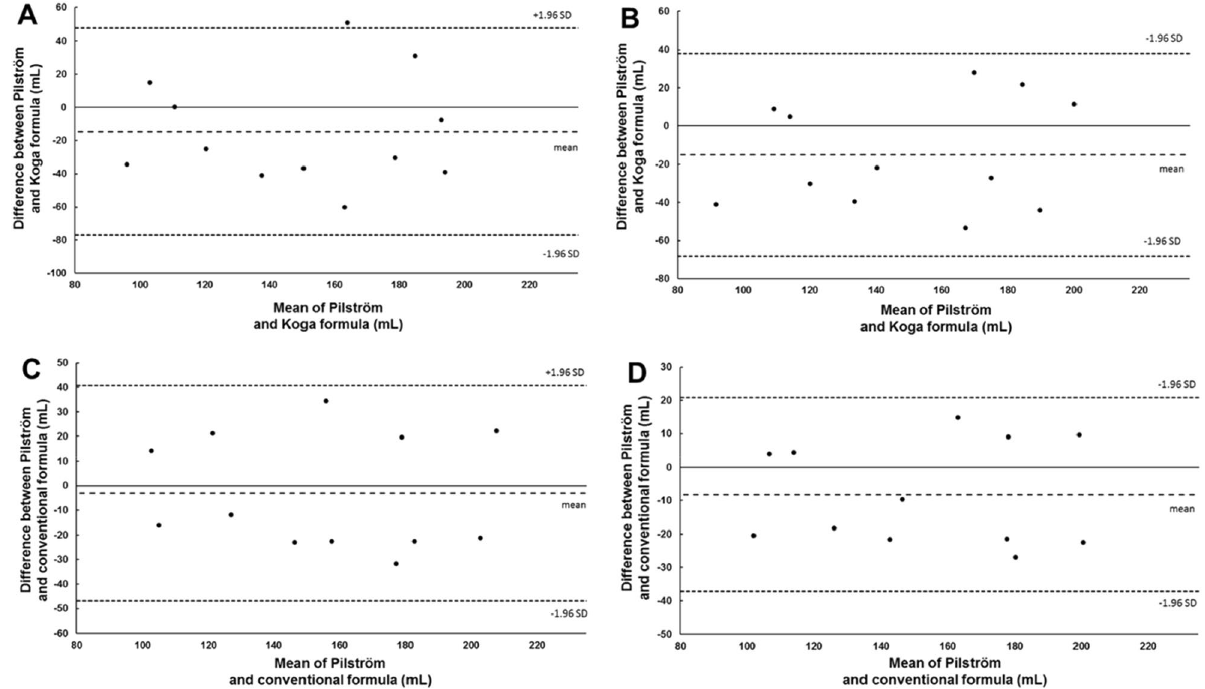
Figure 4. Bland and Altman plot for baseline splenic volume measures. The upper panel displays splenic volume difference (mL; Y-axis) between, and mean splenic volume (mL; X-axis) of formula (1) and formula (3) using ‘two consecutive maximal measures’ ( A ) and ‘mean of all measures’ ( B ). The lower panel displays splenic volume difference (mL; Y-axis) between, and mean splenic volume (mL; X-axis) of formula (1) and the formula (2) using ‘two consecutive maximal measures’ ( C ) and ‘mean of all measures’ ( D ). The bias is represented (middle dotted line) along with zero difference (solid line) with the representation of the upper and lower limits of agreements (small dotted lines), from − 1.96 SD to + 1.96 SD (n =